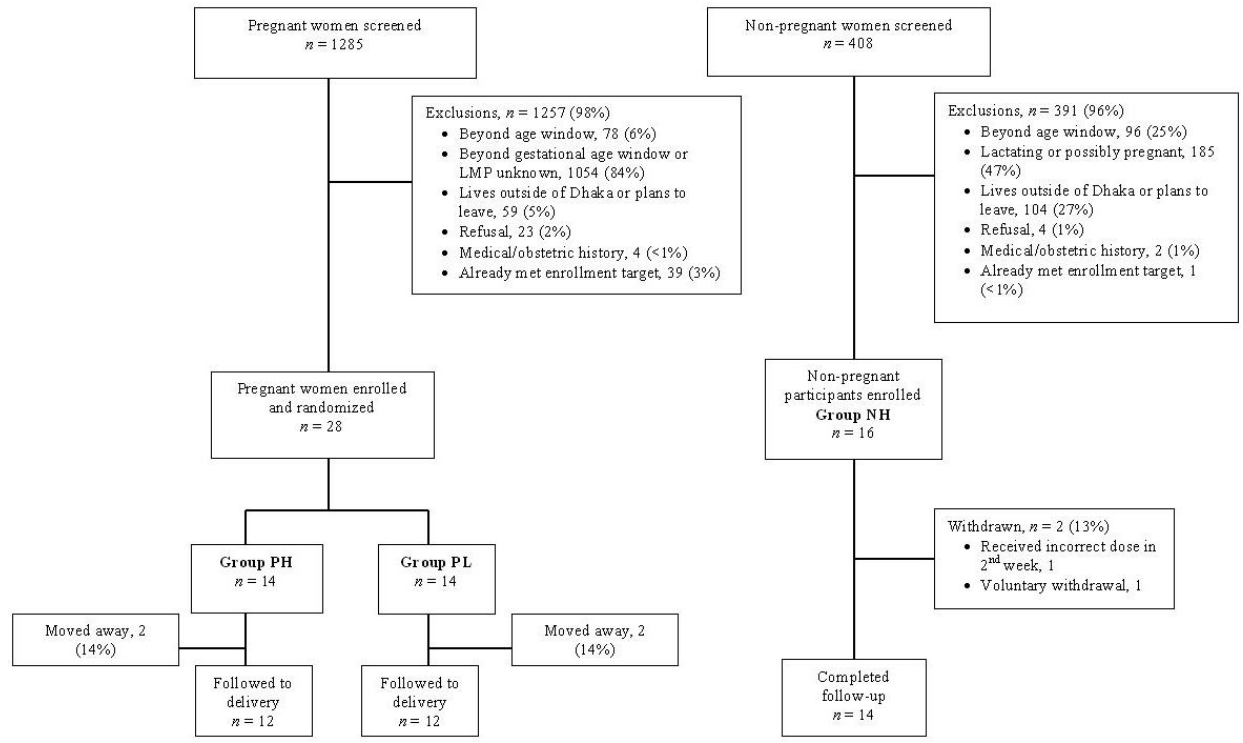
Figure 2. Study flow diagram. Participant screening, enrollment, exclusions, and withdrawal over the course of the